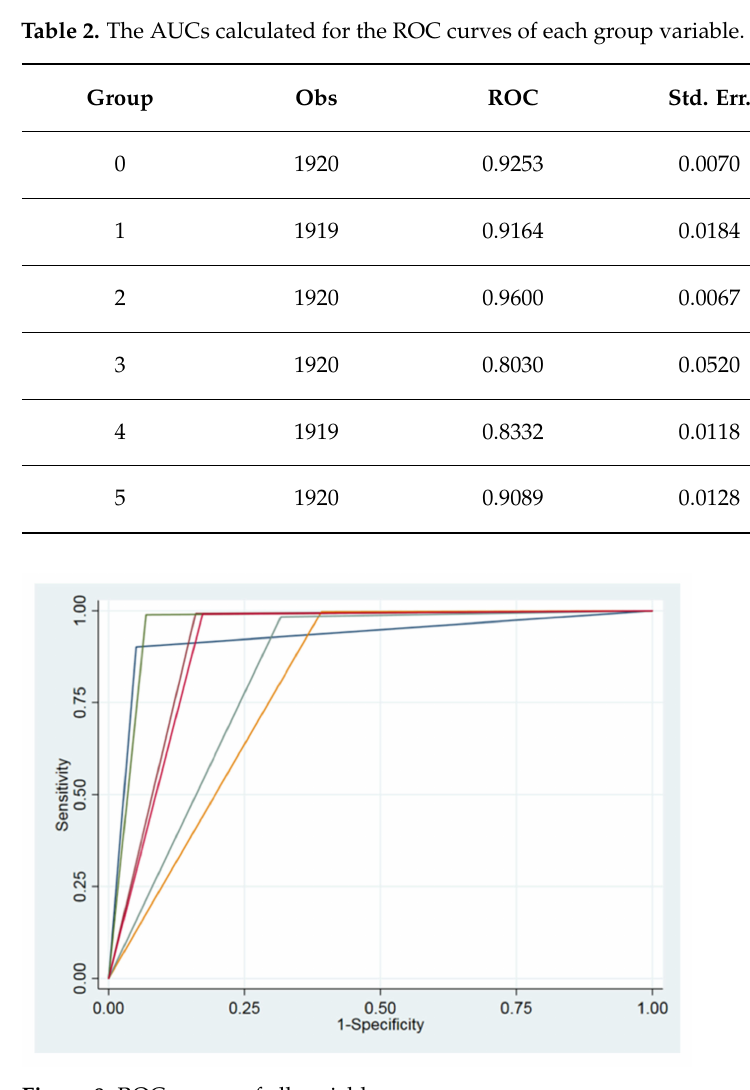
Figure 8. ROC curves of all